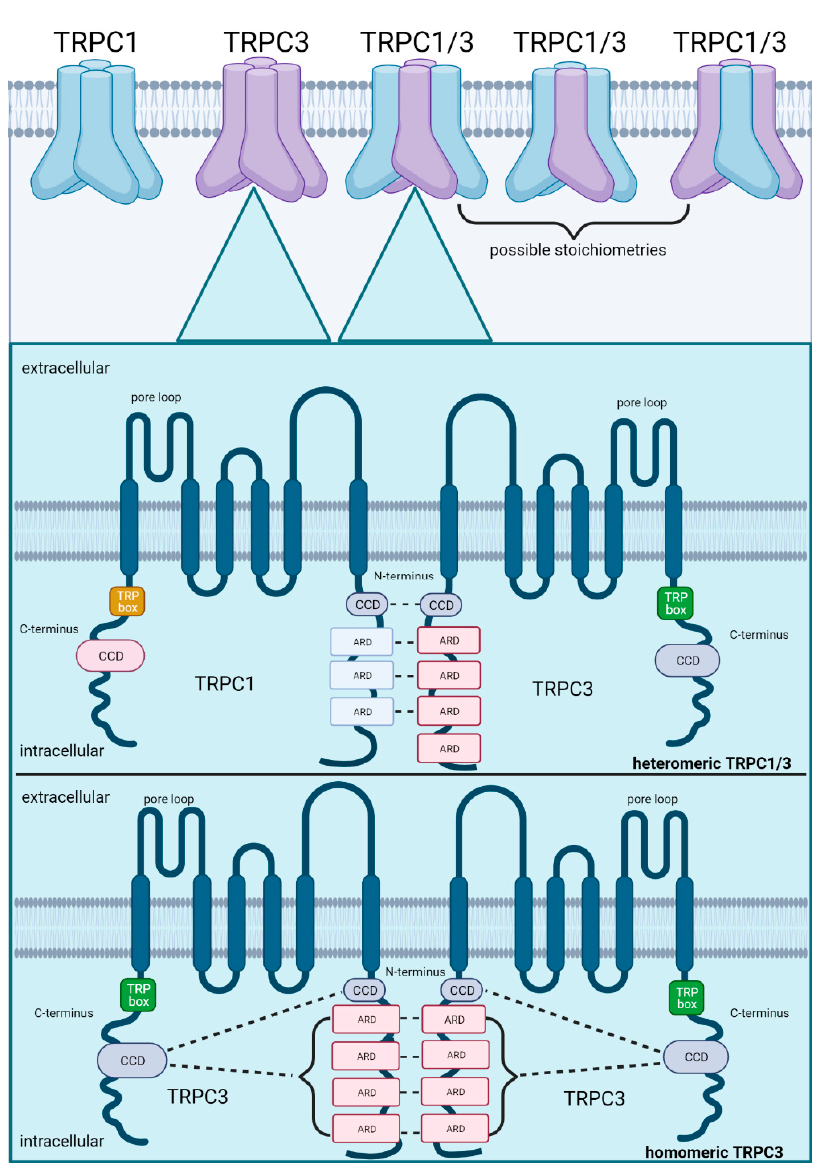
Figure 2. Schematic illustration of subunit assembly for heteromeric TRPC1/3 as compared to homomeric TRPC3. Co-expression of both subunits increases the probability of heteromerization, which is facilitated by their 28.7% amino acid congruency. Possible stoichiometries in a heteromeric assembly comprise 1:3, 2:2 or 3:1 (TRPC1:TRPC3). TRPC1/3 is stabilized by non-covalent interactions between ARDs (ankyrin repeat domains) and CCDs (coiled-coil domains) on their N-termini. In contrast, homomeric assembly of TRPC3 is stabilized by interactions between ARDs on their N- termini and by interactions between the CCDs on their C-termini with the ARDs and CCDs on their N-termini. Created with